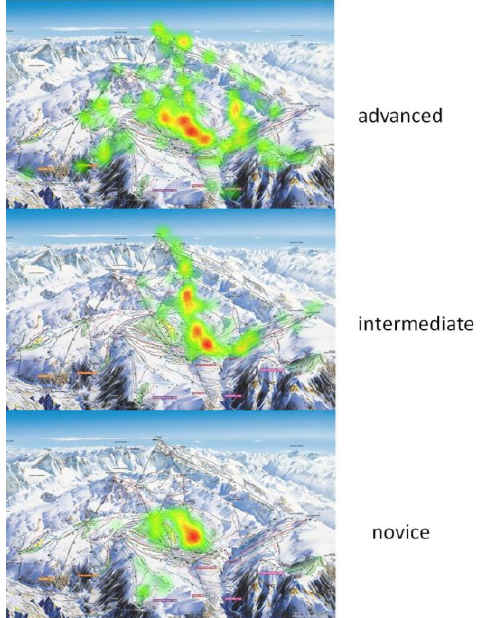
Figure 5 Examples of heatmaps for exploring and assessing the ski resort task (T1)